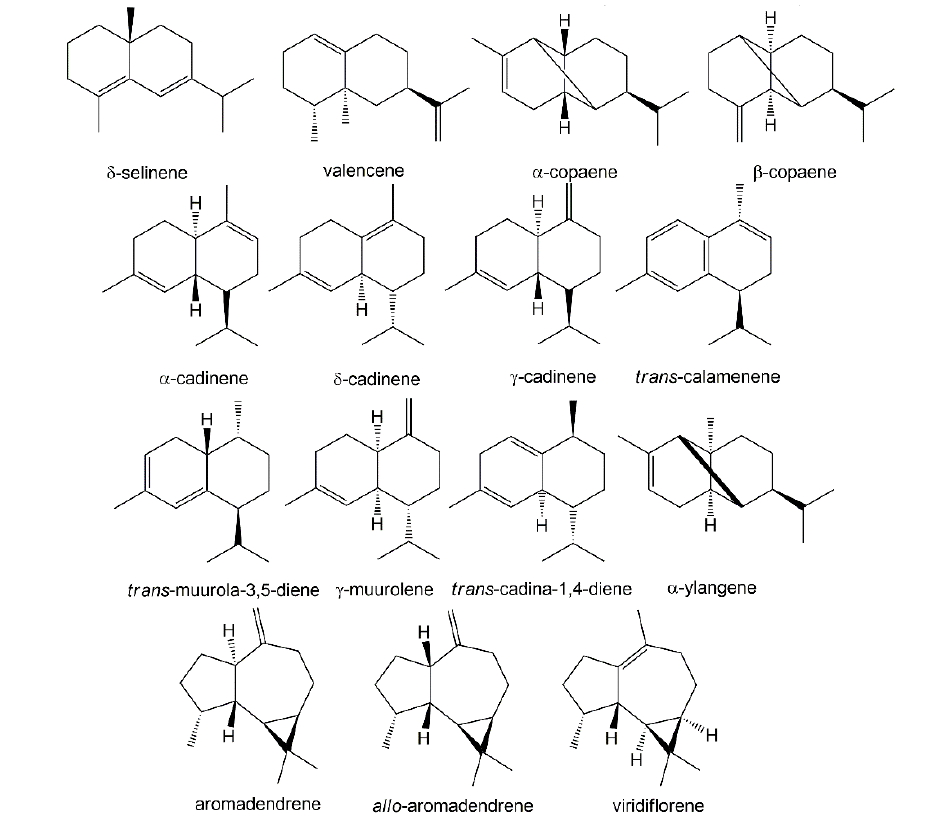
Figure A2. Major sesquiterpene hydrocarbons found in Eugenia and Syzygium essentials oils.